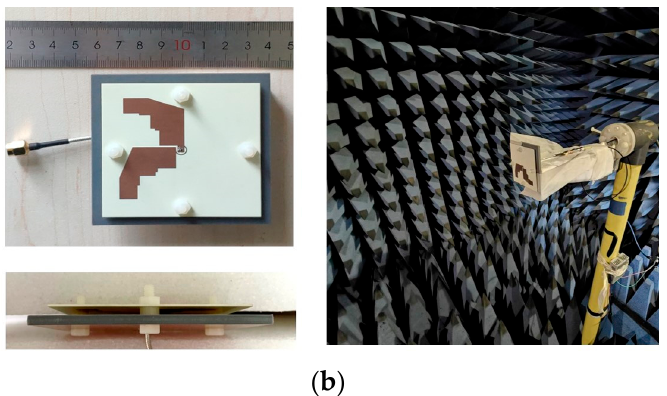
Figure 9. ( a ) Simulated and measured |S 11 |, AR, and boresight gain of the proposed antenna and ( b ) the fabricated prototype and measurement environments.